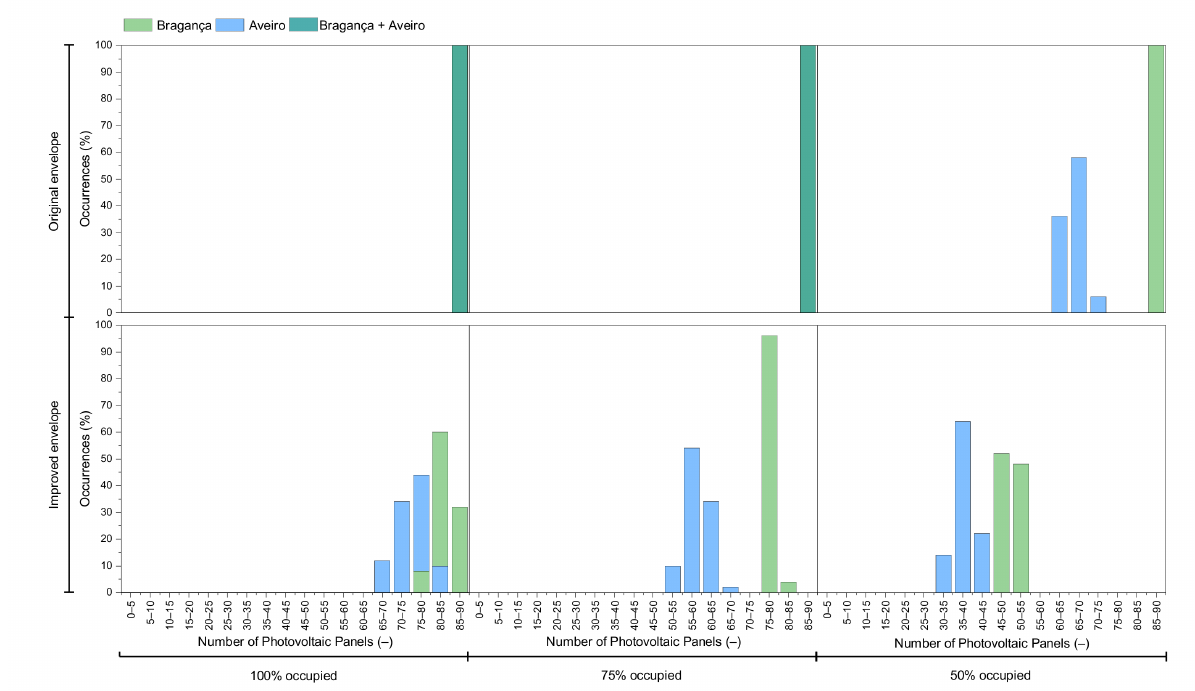
Figure 11. Envelope improvements analysis for heating system with COP